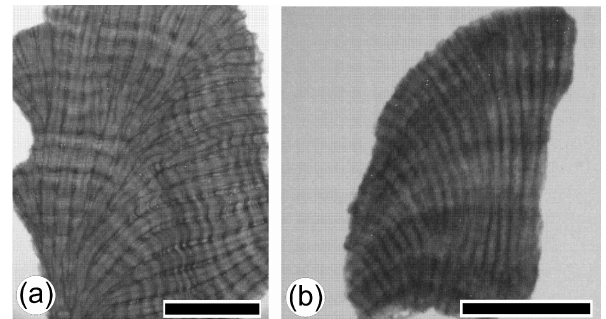
Figure 3. Digital X-ray photographs (positive prints) from fossil z corals. (a) Solenastrea sp. (EP 5, Mule Pen Quarry, Tamiami Fm., age 2.5Ma). (b) Porites sp. (EP3, Mule Pen Quarry, Tamiami Fm., age 2.9Ma). Scale bar